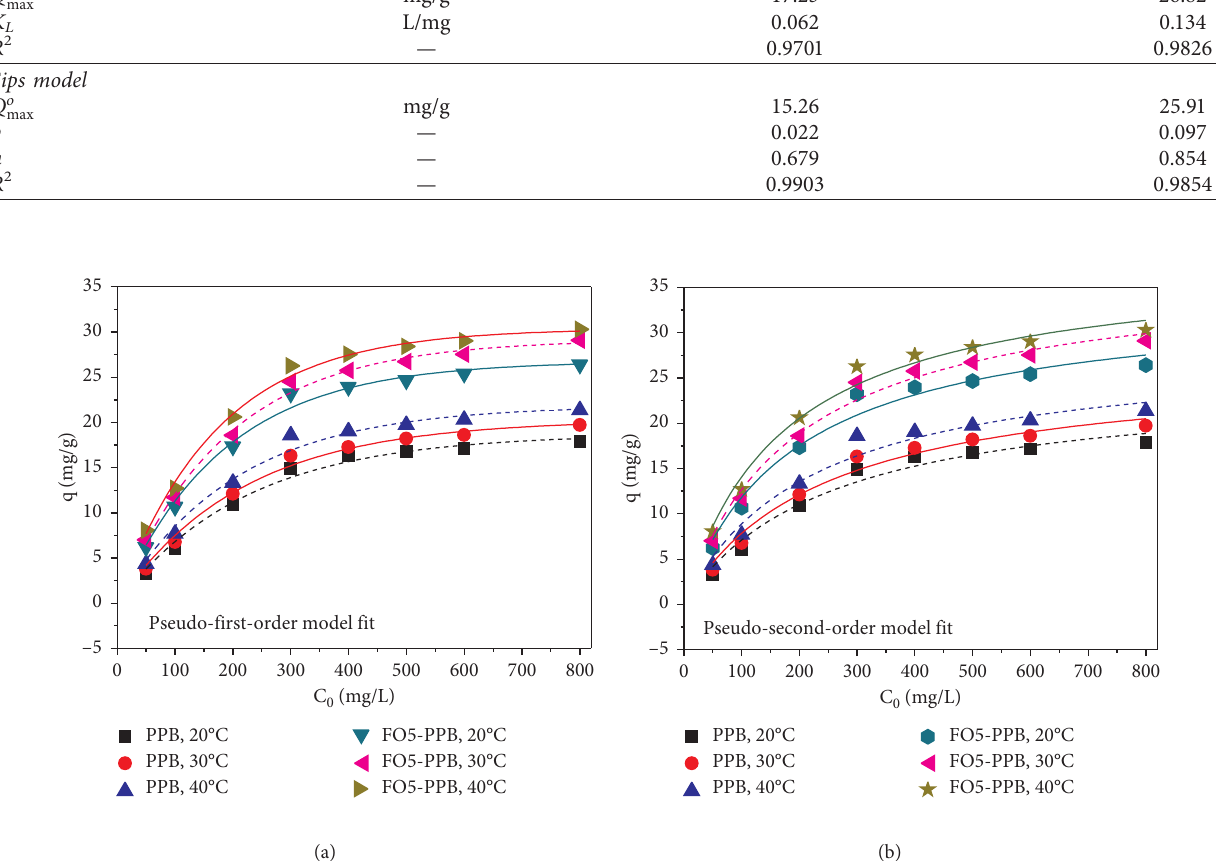
Figure 11: Adsorption kinetic prediction of RR21 onto PPB and FO5-PPB at a contact time of 60min and adsorbent dose of 2g/L at different